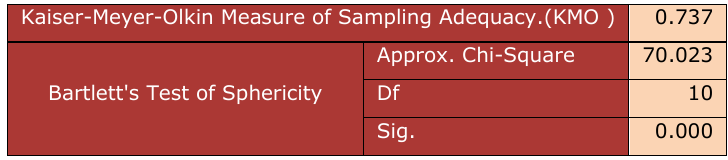
Table 5. KMO and Bartlett's Test